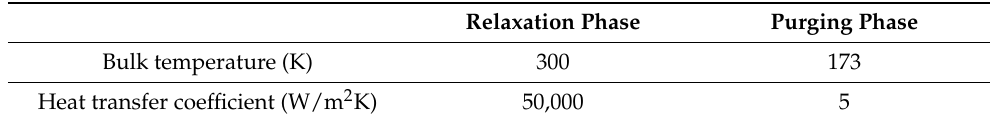
Table 9. Input data for the thermal analysis.